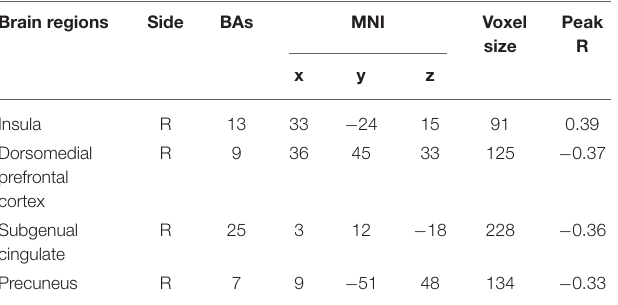
The columns provide anatomical descriptions of the regions of interest: hemisphere side (B: bilateral; R: right; and L: left), Brodmann areas (BAs), the peak Montreal Neurological Institute coordinate, the volume in voxels, and the peak